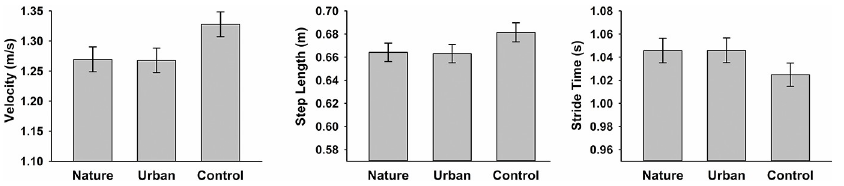
Fig 1. Group (n = 44) averages of individual mean velocity (m/s), individual mean step length (in metres) and individual mean stride time (in seconds) across environment type (nature, urban, control). Error bars reflect ± 1 SEM.